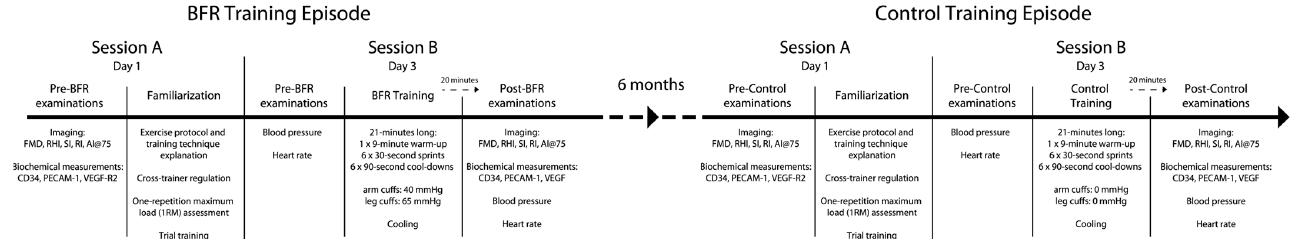
Figure 1. Study timeline.